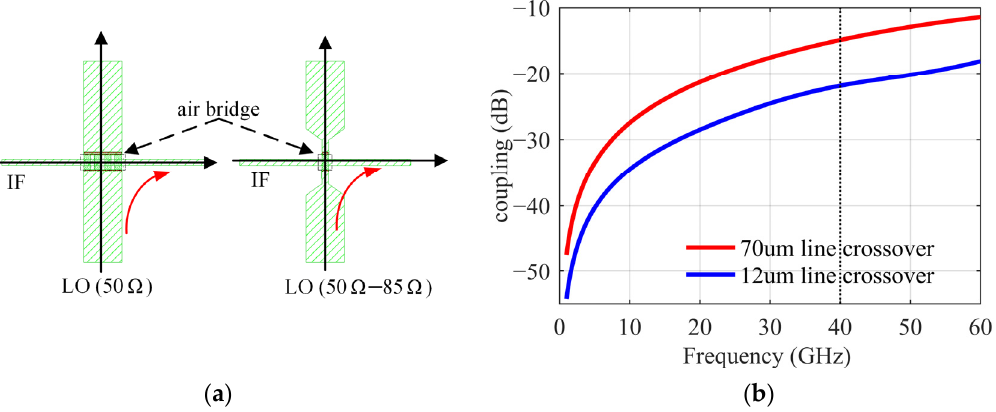
Figure 15. ( a ) Air bridge structure. ( b ) Comparison of two air bridge structures.